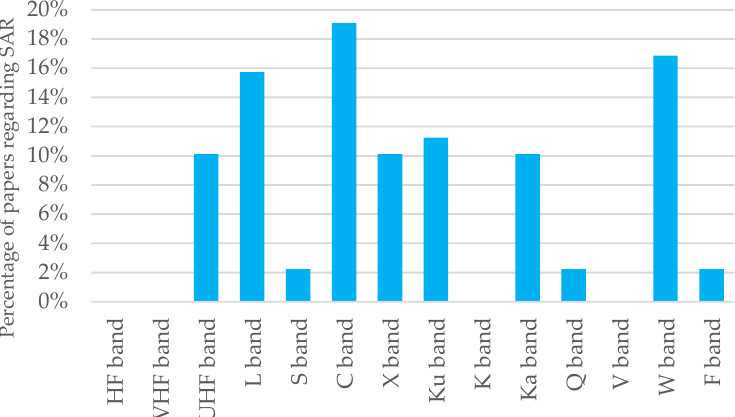
Figure 19. Percentage of papers regarding SAR applications in terms of operative band.